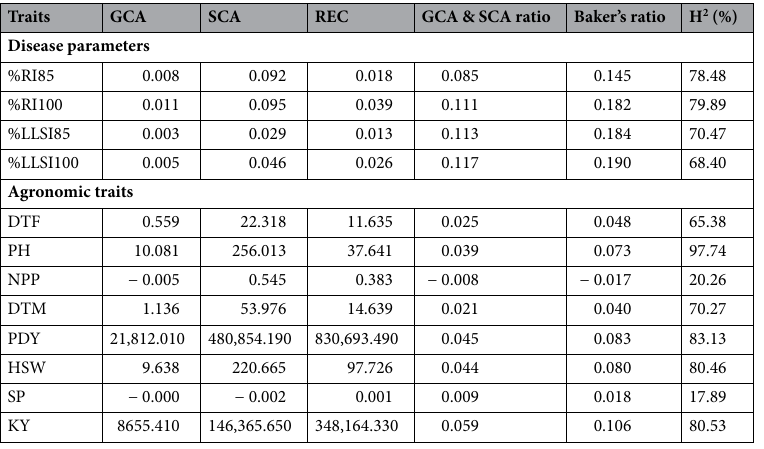
Table 9. Variance components for four-disease parameters and eight agronomic traits of 45 groundnut genotypes evaluated in two seasons. %RI85 percentage rust infection at 85 days after planting, %RI100 percentage rust score infection at 100 days after planting, %LLSI85 Percentage late leaf spot infection at 85 days after planting; %LLSI100 percentage late leaf spot infection at 100 days after planting, DTF days to flowering, PH plant height, NPP number of pods per plant, DTM days to maturity, PDY pod yield, HSW hundred seed weight, SP shelling percent, KY kernel yield, GCA general combining ability, SCA specific combining ability, REC reciprocal, H 2 broad sense